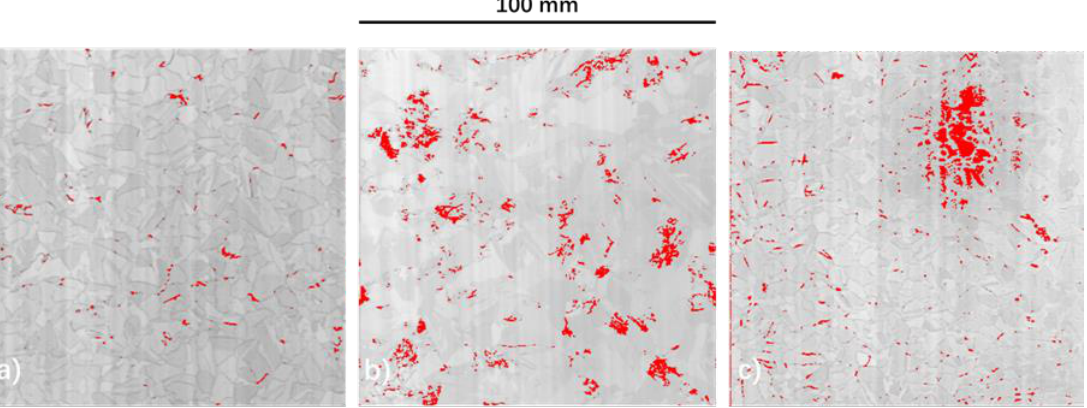
Figure 6. Defect images of Mc-Si bottom wafers assisted by ( a ) electrophoretic deposited quartz powder, ( b ) spray quartz powder, and ( c ) silicon particles.